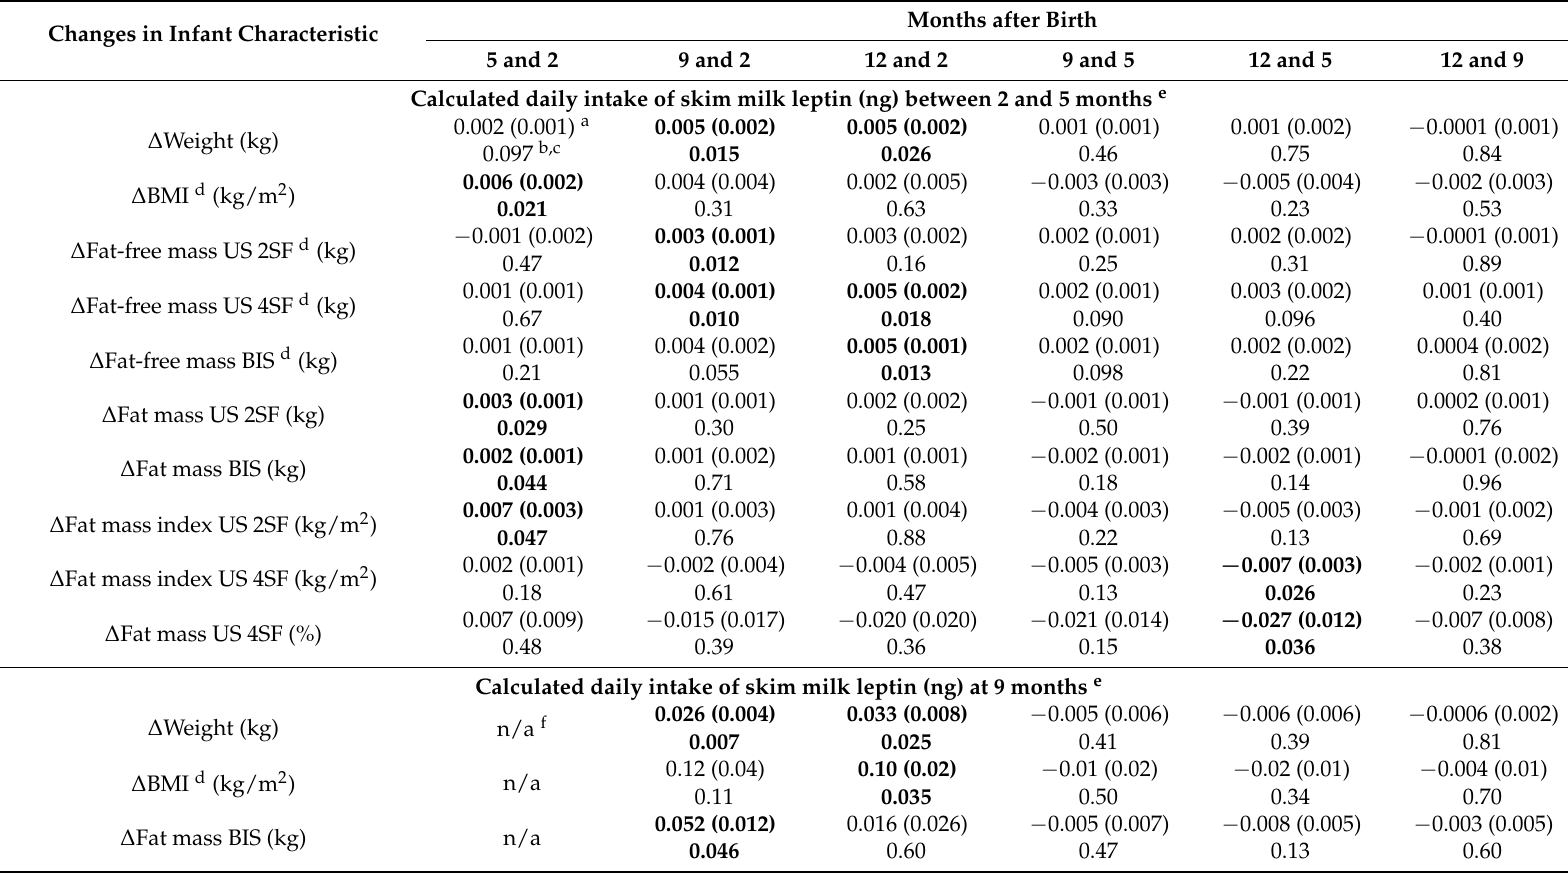
Table A6. Associations between calculated daily intakes of skim human milk leptin at given time points and infant body composition changes between the time points. Changes in Infant Characteristic